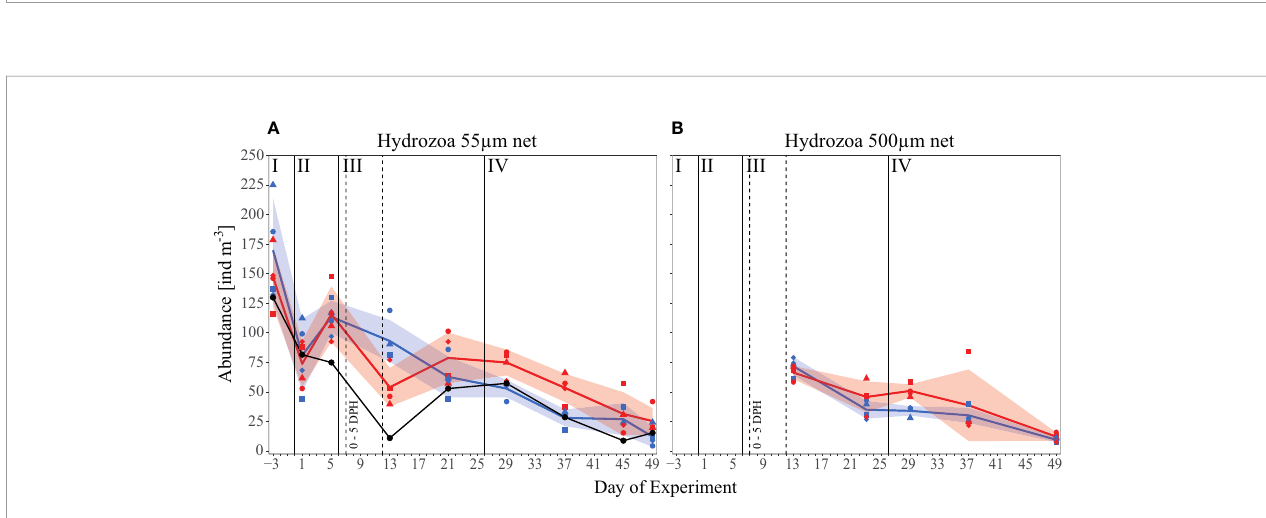
FIGURE 4 | Main Hydrozoa species observed: (A) Aglantha digitale , (B) Clytia sp., (C) Sarsia tubulosa , and (D) Obelia geniculate . Displayed organisms are not to scale to each other. Pictures © Solvin